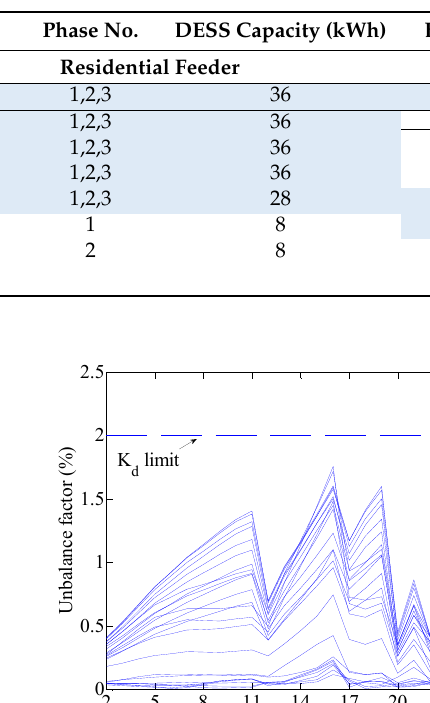
Table 9. Case Study 3: DESS Allocation results.